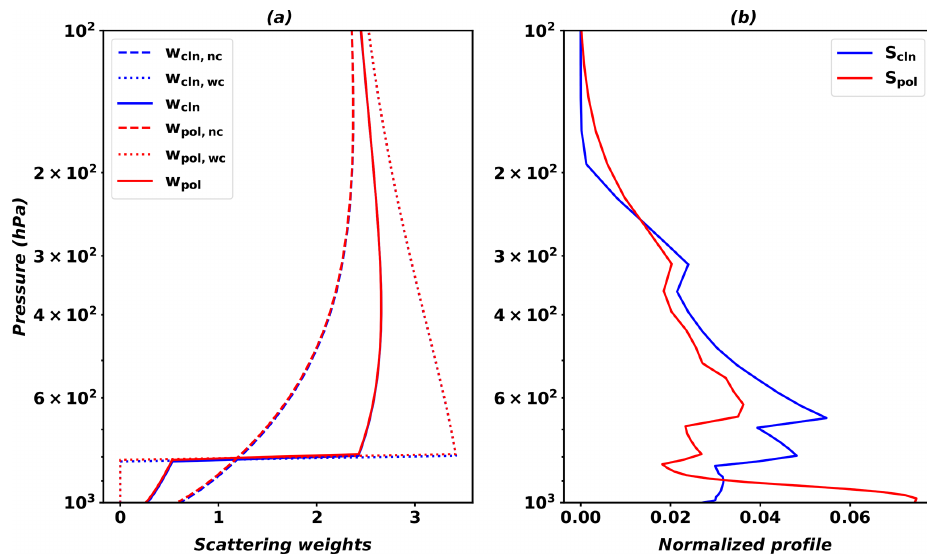
Figure 4. Scattering weights (a) and normalized profiles (b) from the AMF LUT over clean (blue) and polluted (red) grids. Dashed and dotted lines in (a) indicate scattering weights with no cloud (nc) and with cloud (wc), respectively. The solid line in (a) indicates scattering weights for a partial cloudy scene calculated using Eq.